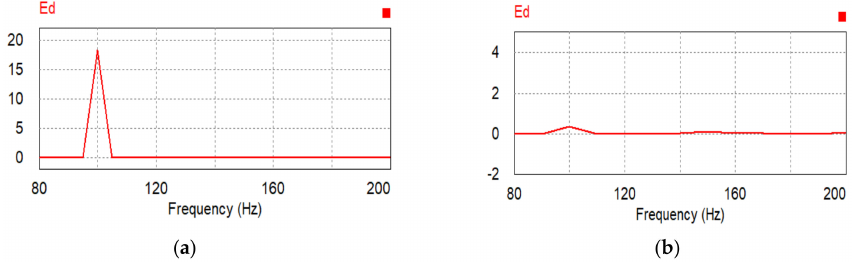
Figure 21. FFT analysis of resonant controller under an unbalanced load. ( a ) Conventional controller; ( b ) Resonant controller.